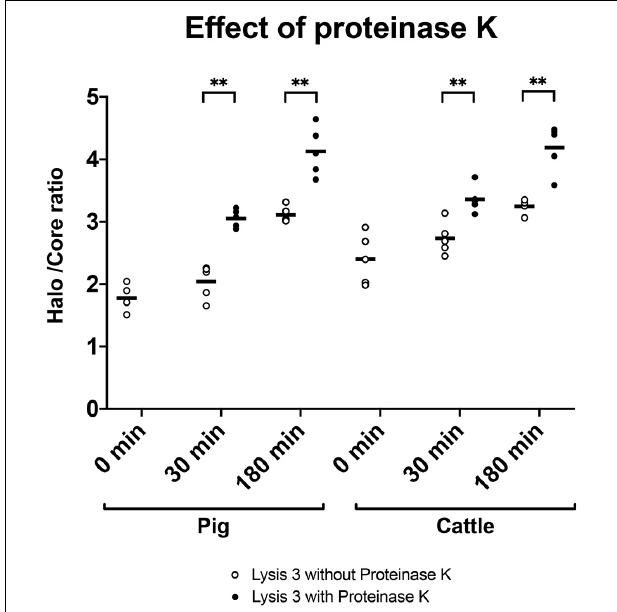
FIGURE 4 | Halo/core ratios for incubations (0, 30, or 180 min) of pig and cattle sperm in the third lysis solution without (empty dots) or with proteinase K (filled dots). ∗∗ Statistically significant differences ( P <